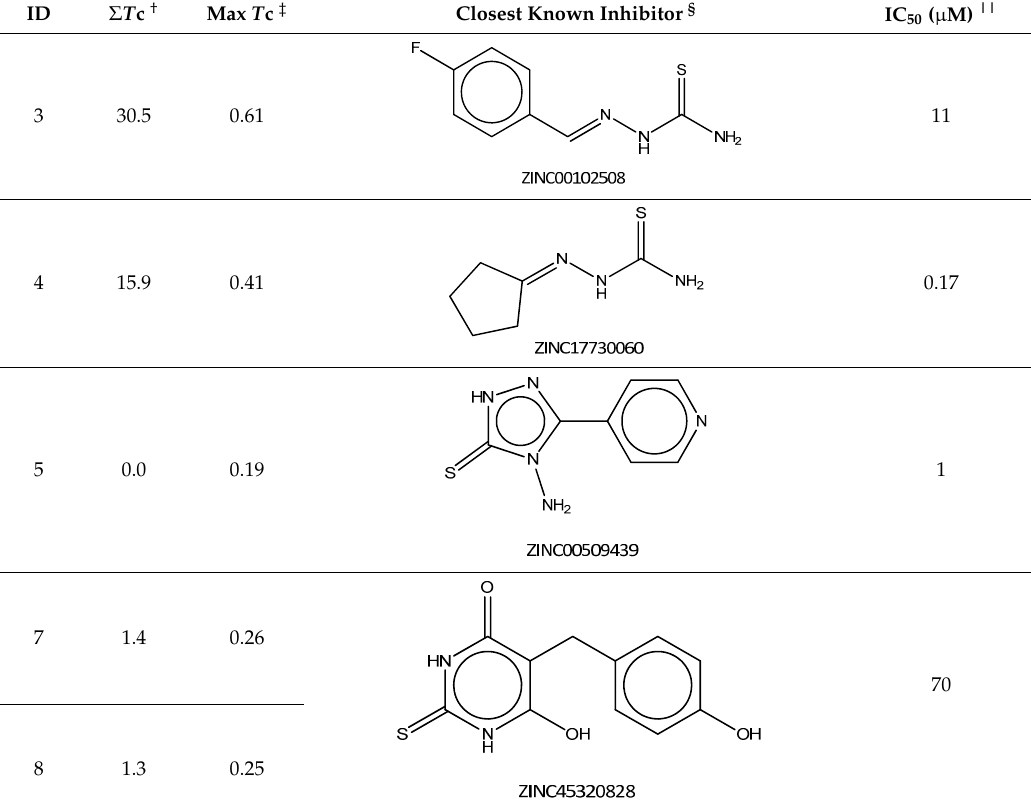
Table 4. Quantified chemical similarity to known tyrosinase inhibitors.